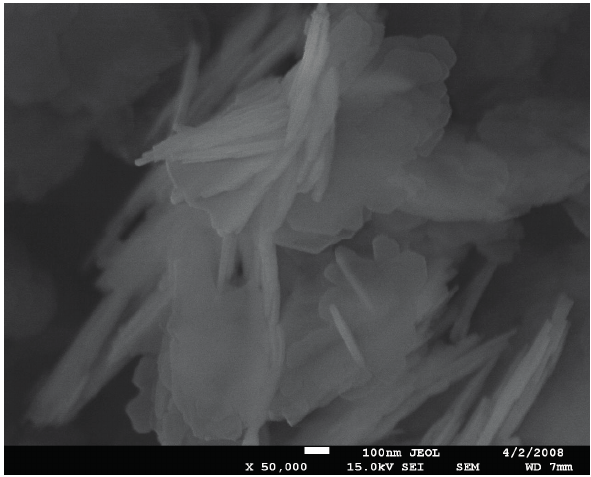
Figure 5. SEM microphotograph of MCM-22 type zeolite.